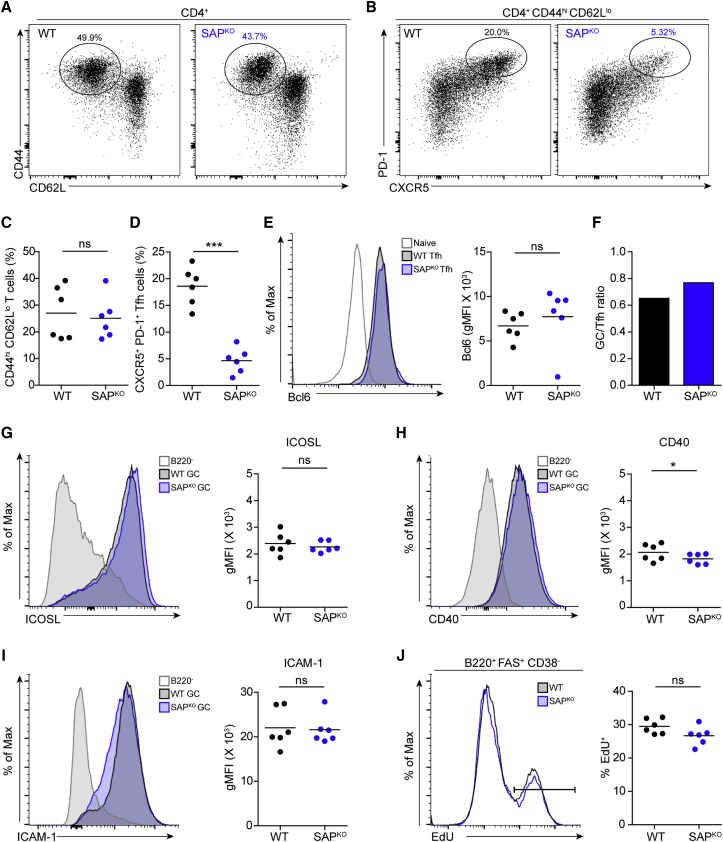
The Proportion of Tfh Cells in PP GCs Is Maintained in SAP-Deficient Mice(A) Representative flow cytometry plots showing activated Th cell (CD44hi CD62Llo) frequencies in the PPs of WT and SAPKO mice.(B) Representative flow cytometry plots showing Tfh cells (CXCR5+ PD-1+) gated from the activated T cell population in the PPs of WT and SAPKO mice.(C and D) Graphs showing the frequencies of CD4+ activated (C) and Tfh cells (D), as in (A) and (B), respectively.(E) Representative histogram showing Bcl6 expression in WT and SAPKO Tfh cells. Expression in naive T cells is shown as a negative control, and frequencies are summarized in the graph.(F) Graph showing the ratio between GC B cells and Tfh cells in WT and SAPKO PPs.(G–I) Representative histogram and quantification of ICOSL (G), CD40 (H), and ICAM-1 (I) expression in PP GC B cells.(J) Representative flow cytometry plots showing EdU uptake by WT and SAPKO GC B cells, 2.5 h following EdU administration. Frequencies of EdU+ cells are summarized in the graph.Data are pooled from two independent experiments, with three mice in each experiment. Each dot represents a single mouse; line represents the mean. ∗p < 0.05, ∗∗∗p < 0.0001, two-tailed Student’s t test. ns, not significant.